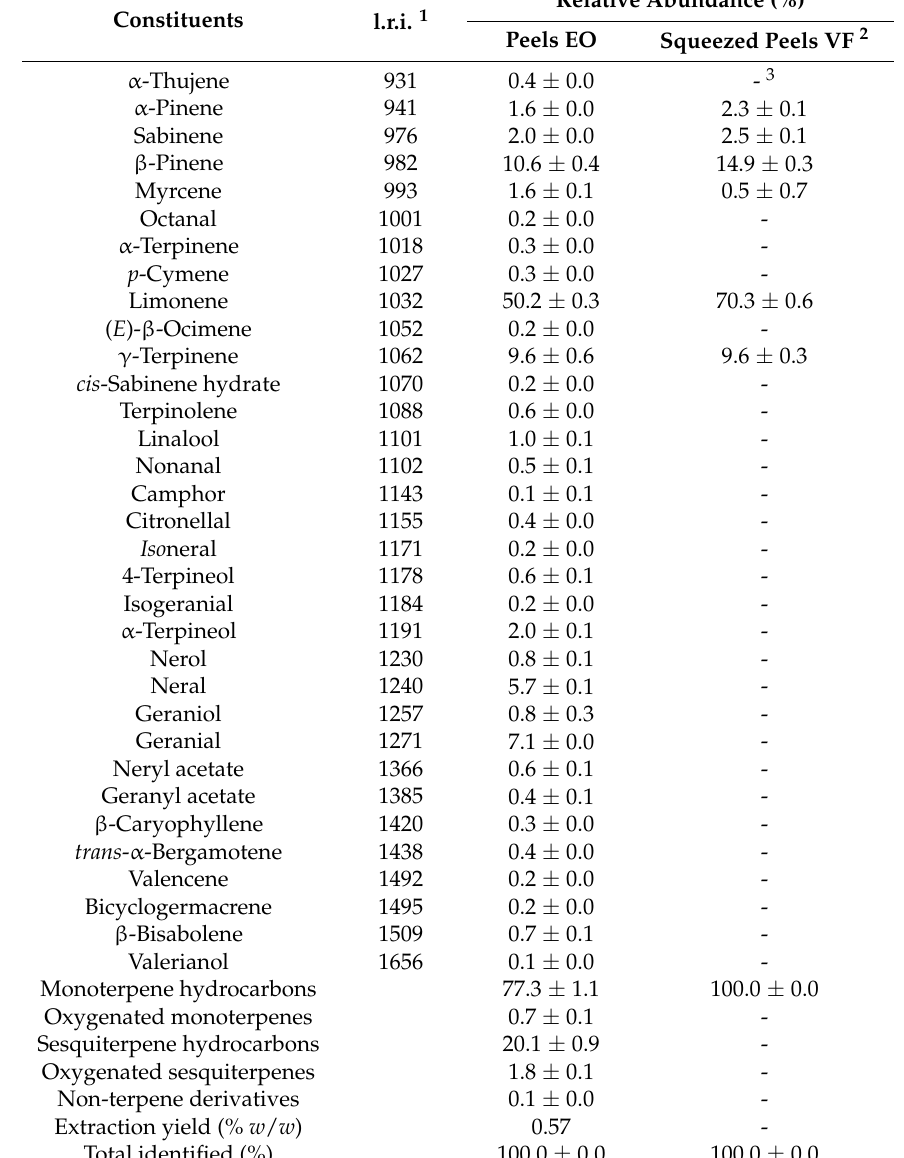
Table 1. Complete compositions of the essential oils of the peels of the lemon ( Citrus limon (L.) Osbeck), both manually squeezed and